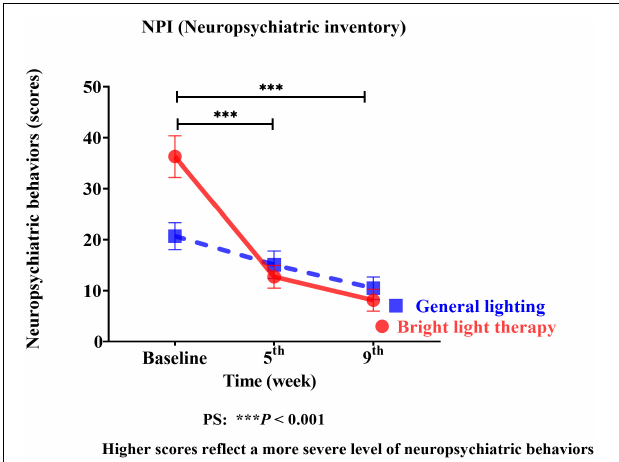
FIGURE 4 | The experimental group showed a significant improvement in the MMSE score (Wald’s test = 7.2, P < 0.007; Wald’s test = 3.9, P = 0.04) from baseline to the 5th and 9th weeks compared with the comparison